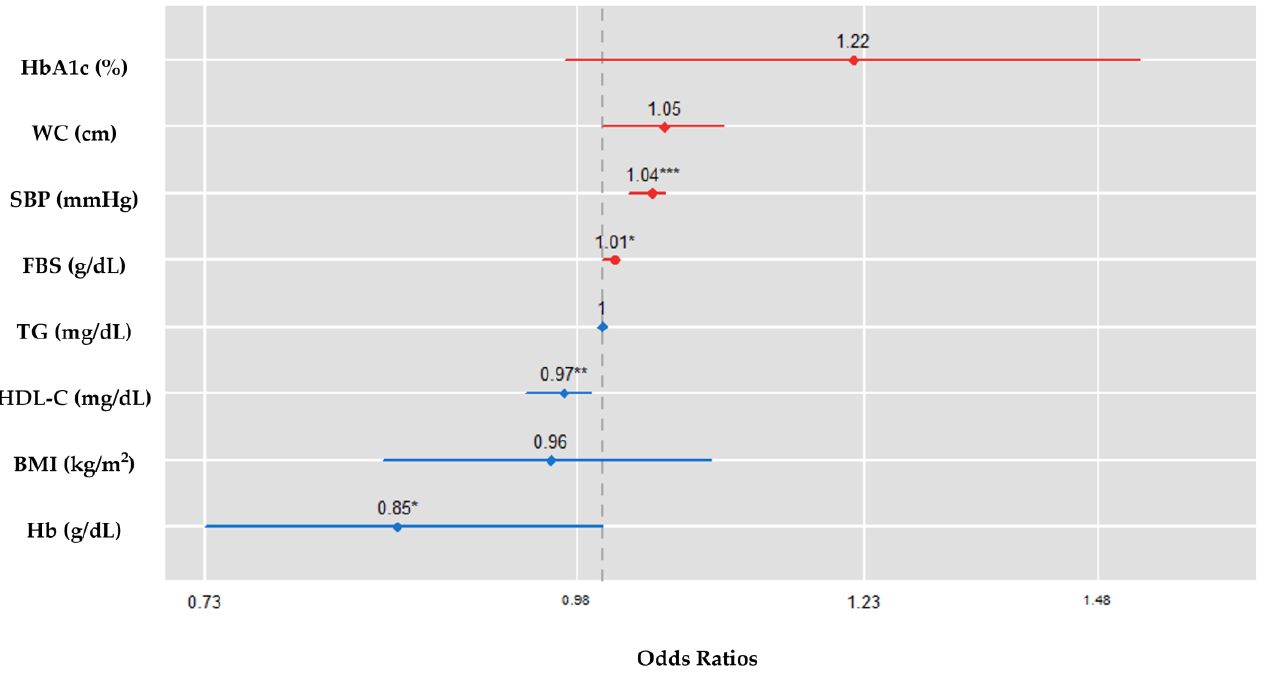
Figure 1. Comparison of the odds ratios by independent variable in the reduced logistic regression model. Abbreviations: HbA1c, glycosylated hemoglobin; WC, waist circumference; SBP, systolic blood pressure; FBS, fasting blood sugar; TG, triglycerides; HDL-C, high density lipoprotein cholesterol; BMI, body mass index; Hb, hemoglobin. * A p -value of <0.05 is considered significant. ** A p -value of <0.01 is considered significant. *** A p -value of <0.001 is considered significant.